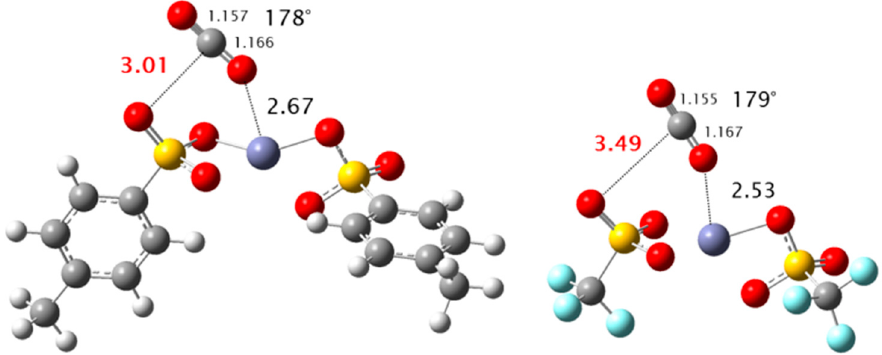
Figure 3. Optimized geometries (CAM-B3LYP / aug-cc-pVDZ) of the structures of the ZnTos-CO 2 ( left ) and Zn(OTf) 2 -CO 2 ( right ) complexes. Bond lengths of interest are displayed in Ångström (dashed lines). The intramolecular C–O distances and OCO angle of CO 2 are also displayed.